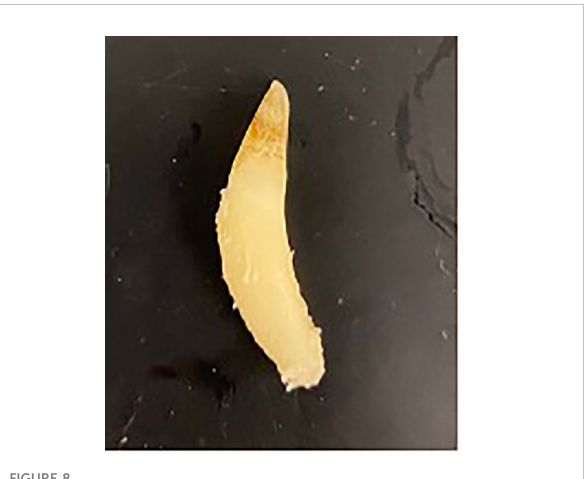
FIGURE 8 A tooth from an adult male dolphin demonstrating the potential elliptical curvature which can make aging via GLG more challenging. Image courtesy of W. McFee.